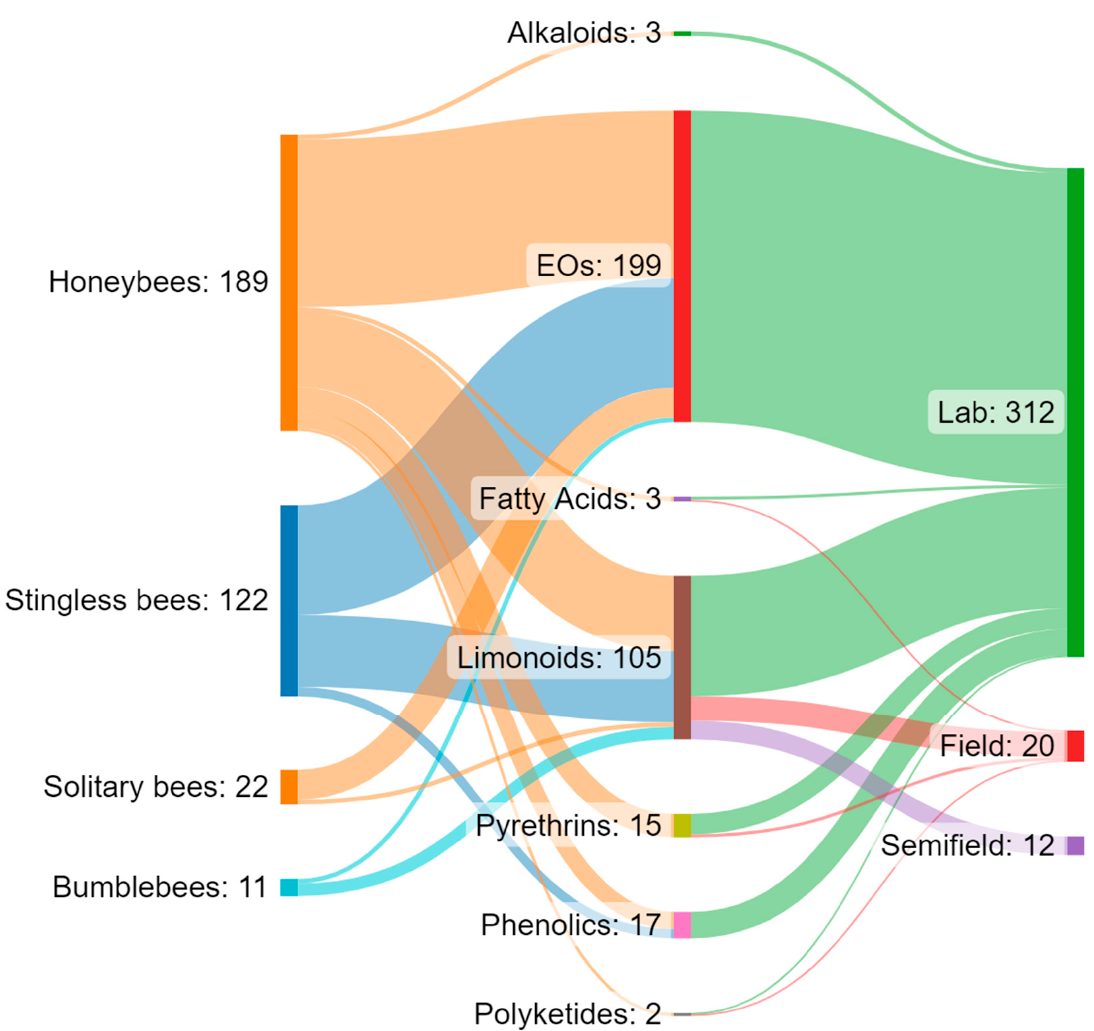
Figure 2. Sankey diagram showing the interaction flows between the groups of bees, different categories of botanical biopesticides, and the type of assay. The reported values refer to the number of trials ( n = 344) found from the analysed papers ( n = 54). Table 3. Classes of sublethal effects caused by botanical biopesticides reported in the reviewed studies on different groups of Hymenoptera Apoidea. In parentheses the total number of studies and the number of studies showing a significant detrimental effect.